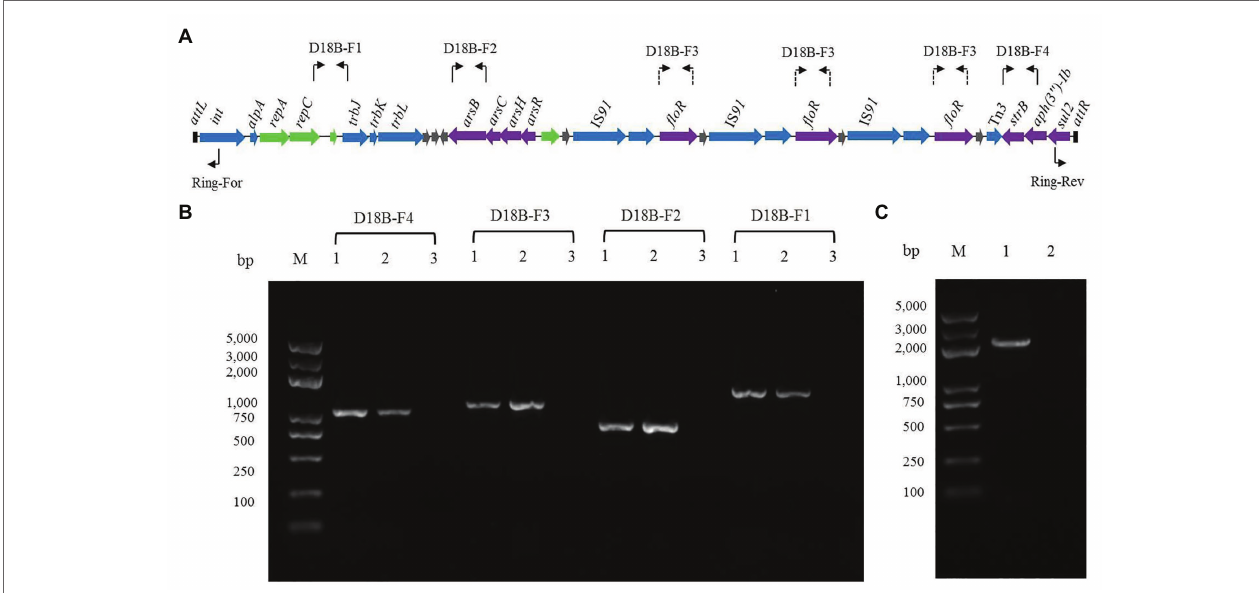
FIGURE 3 | Verification of the presence and the circular form of ICE Rsp D18B. (A) Primer positions in ICE Rsp D18B are indicated using bent arrows. As ICE Rsp D18B harbors three copies of floR , primers for determination of the presence of floR are shown in three locations by dashed arrows. (B) Four ICE Rsp D18B fragments were amplified by PCR using total DNA of transconjugant 25D18-B4 (lanes 1), strain D18 (lanes 2), strain 25DN (lanes 3) as templates. (C) Verification of the circular form of ICE Rsp D18B using the primer pair Ring-For/Rev. Total DNA of strain D18 (lane 1) or strain 25DN (lane 2) was used as template. M, molecular size